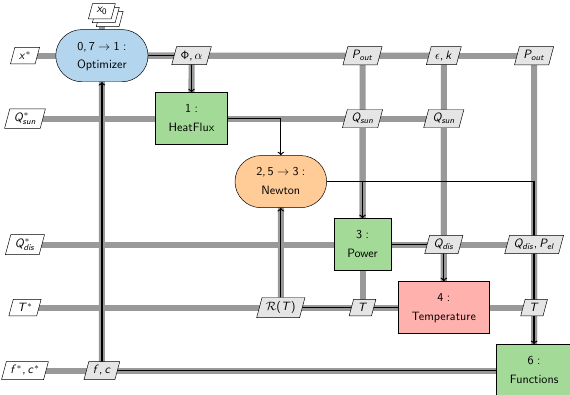
Figure 4. MDF architecture of example thermal problem